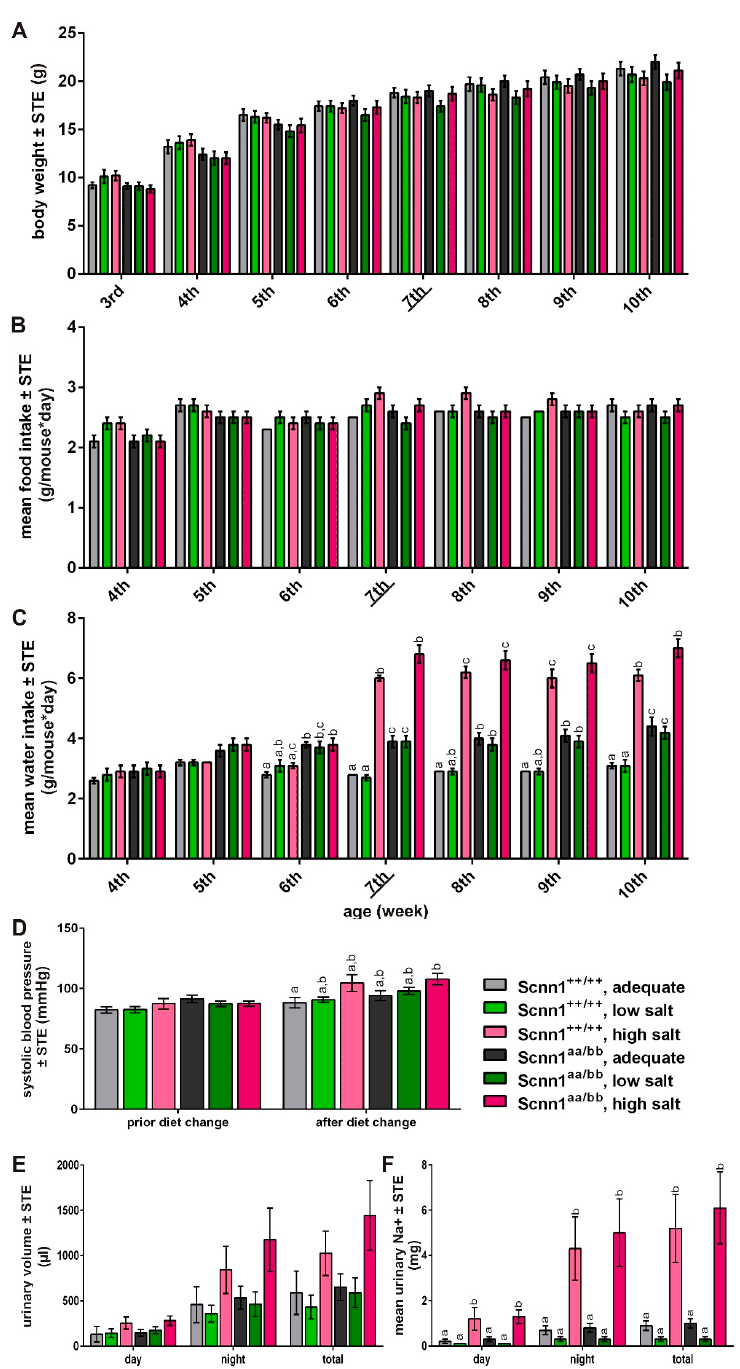
Figure 1. Physiological parameters of Scnn1 ++/++ and Scnn1 aa / bb mice during dietary monitoring. ( A ) Body weight, ( B ) food and ( C ) water intake, ( D ) blood pressure, ( E ) urinary volume, and ( F ) sodium excretion of Scnn1 ++/++ ( n = 11) and Scnn1 aa / bb mice ( n = 19–20) fed with low salt, adequate, and high salt diet over a period of 4 weeks (7th to 10th week, time point of diet change is indicated by underline); after initial 3 weeks of sodium adequate chow diet (4th to 6th week) after weening (3rd week). Statistical di ff erences between 2 bars at a specific time point are indicated by di ff erent letters based on UNIANOVA and post-hoc analysis using Bonferroni´s multiple comparison